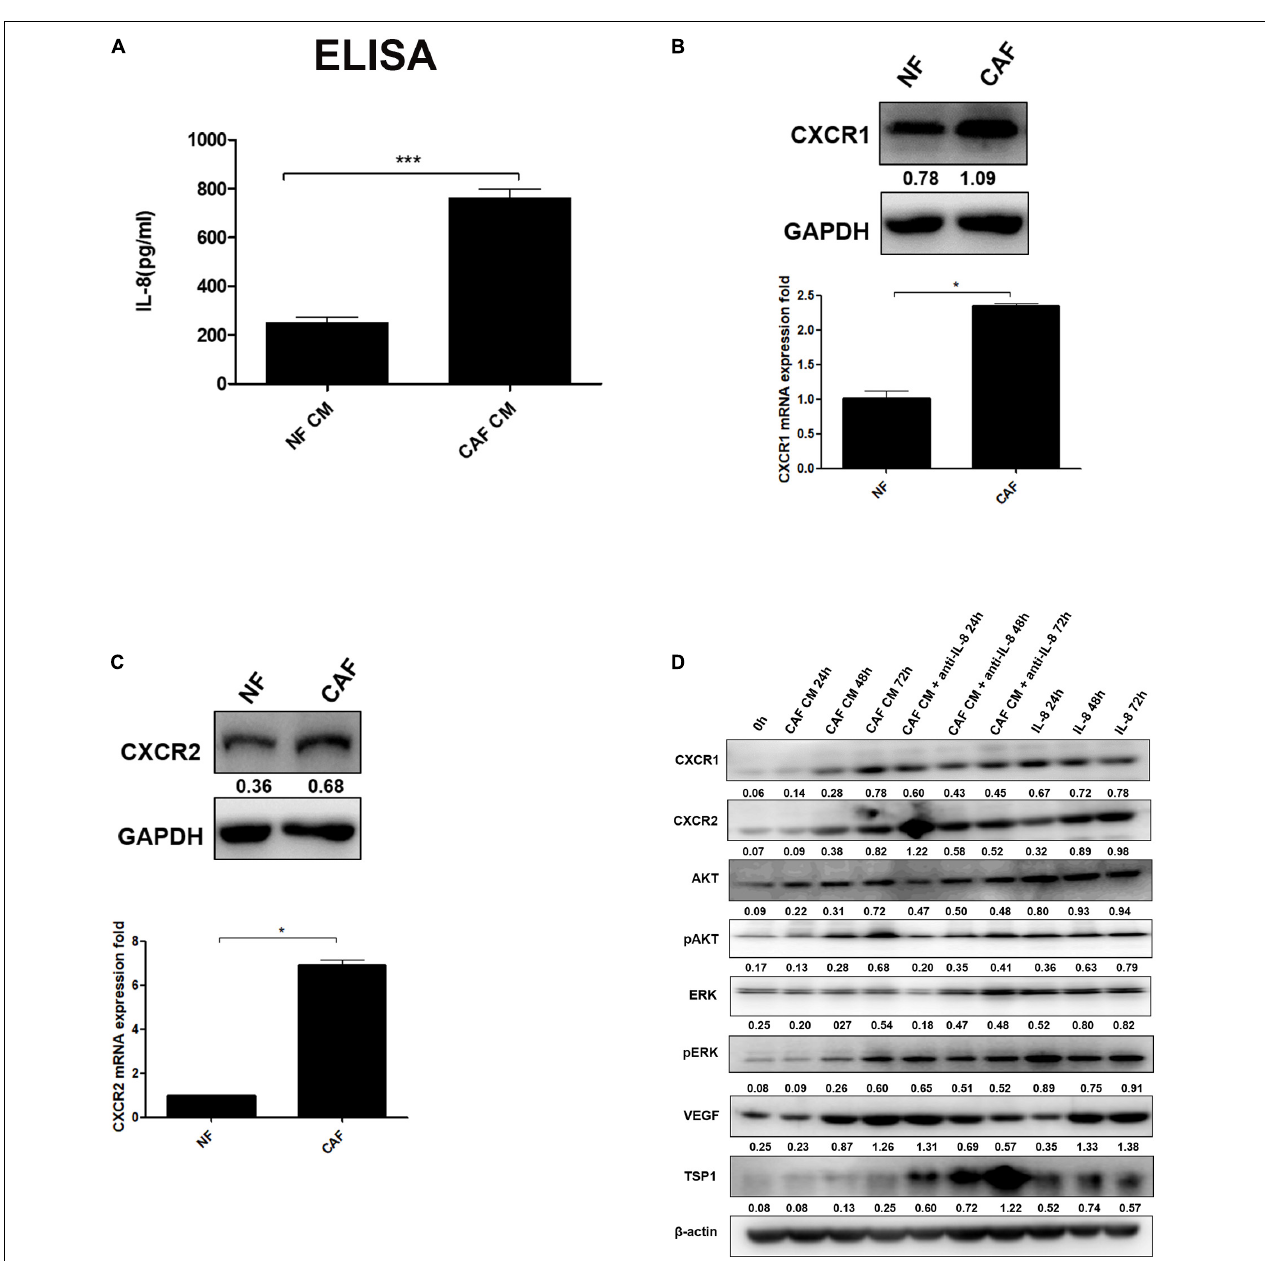
FIGURE 1 | IL-8 activates NFs in multiple signal pathways. (A) Measurement of IL-8 in CAF CM and NF CM by ELISA. (B,C) Detection of CXCR1 and CXCR2 in NFs and CAFs by Western blotting and qRT-PCR. Triple independent experiments were carried out, and representative results are shown. (D) Analysis of AKT/ERK-associated proteins including CXCR1/2, AKT, pAKT, ERK, pERK, and angiogenesis-related proteins (VEGF and TSP-1) by Western blotting in NFs treated with CAF CM, CAF CM + anti-IL-8, and IL-8 alone. β -Actin was used as a loading control. * p < 0.05, *** p < 0.001. IL, interleukin; NFs, normal ovarian fibroblasts; CAFs, cancer-associated fibroblasts; CM, conditioned media; VEGF, vascular endothelial growth factor.